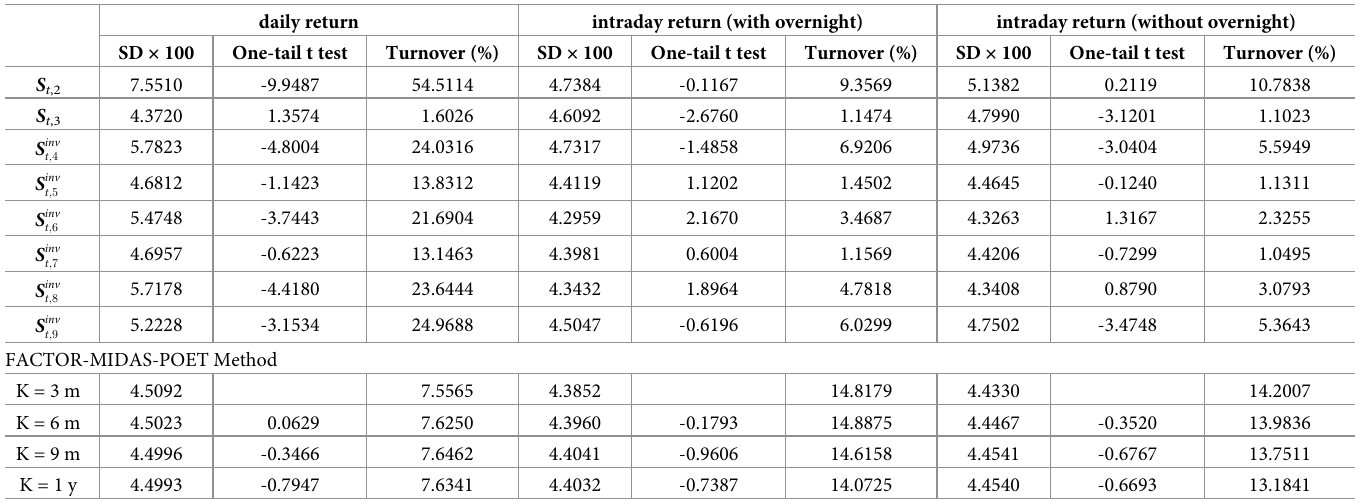
Table 10. Out-of-sample performances of portfolios with T = 3 m. daily return